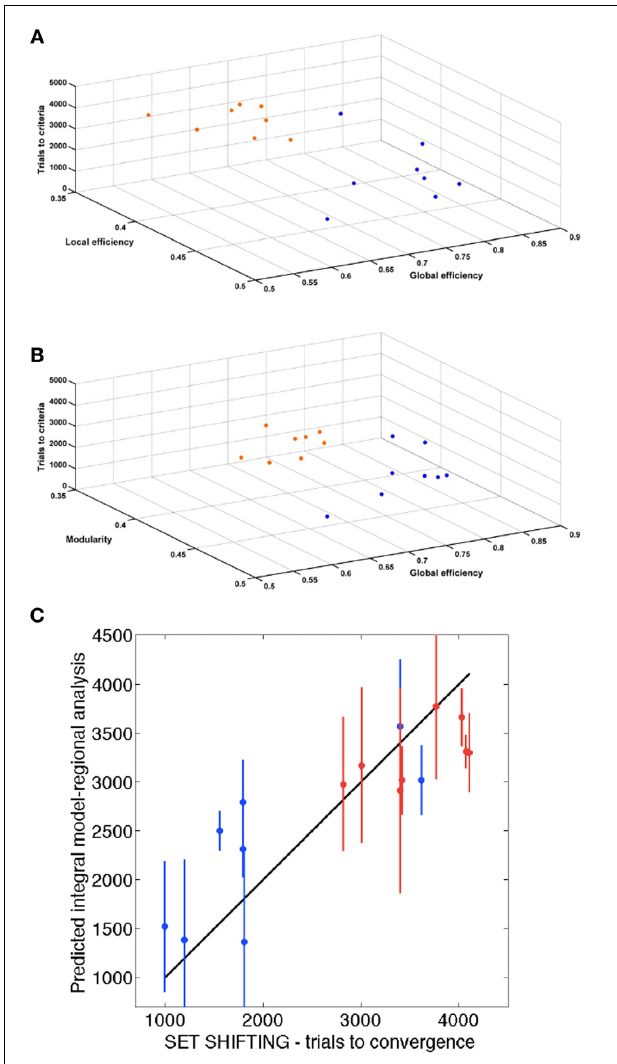
FIGURE 7 | Association of behavior and connectivity indices. (A,B) Scatter plots representing all the animals with the number of trials required to reach criteria in the set-shifting test on the Y axis, and the connectivity indexes in the X and Z axis. Blue dots represent control animals and orange dots represent SHR. (C) Estimation of the final behavioral flexibility score of each animal based on the connectivity indexes at 10 weeks.